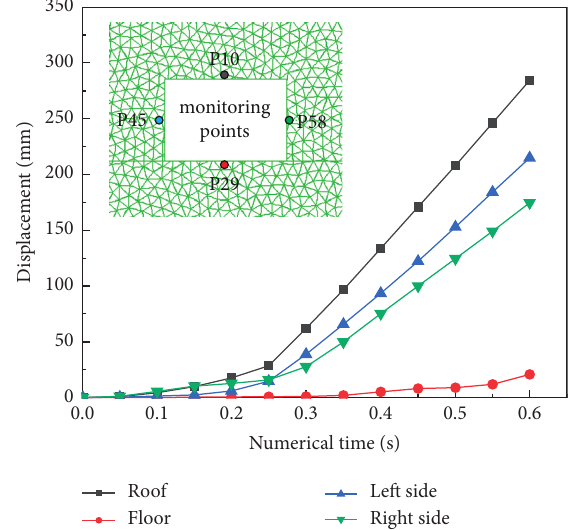
Figure 12: Simulated displacement curve of the surrounding